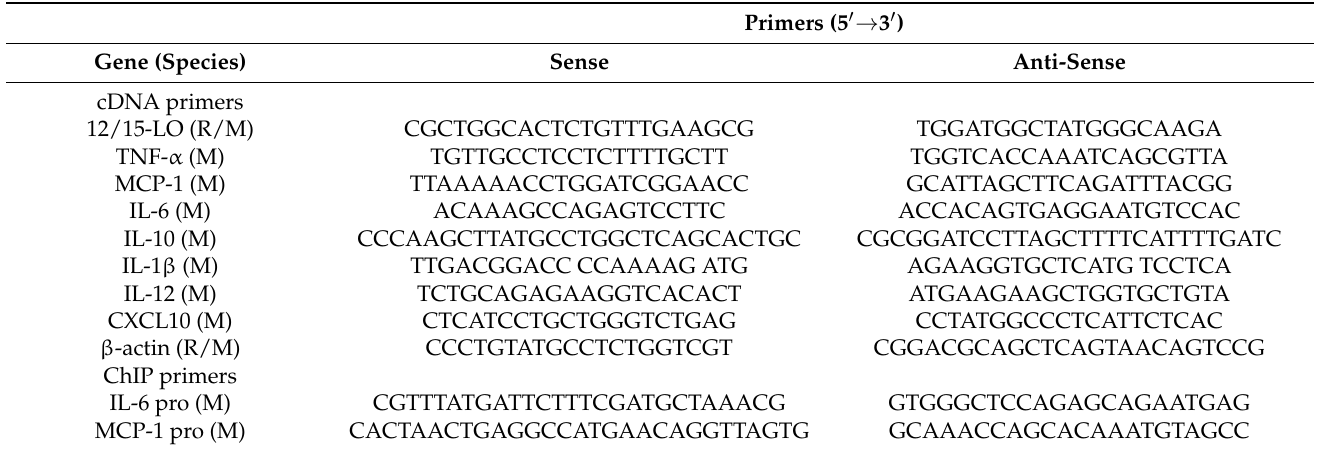
Table 1. Primer sequences used in RT-qPCR analysis and ChIP